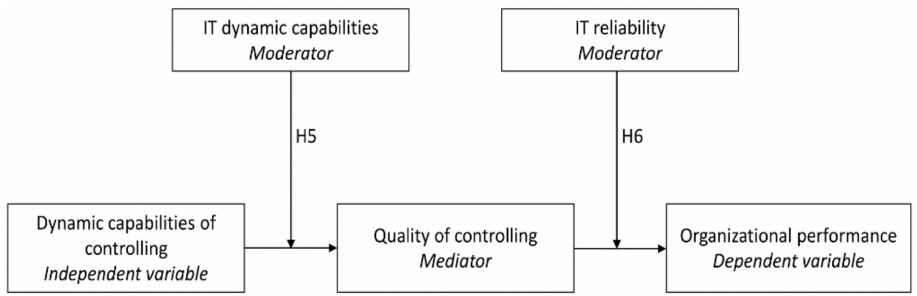
Figure 2. Moderators of model of DC of controlling influence on organizational performance; source: own work.